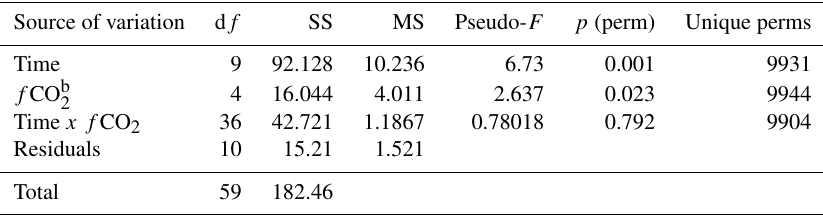
Table 3. Results of two-factor permutational multivariate analysis of variance (PERMANOVA) a on a resemblance matrix (Euclidian distance) based on normalized metabolic variables (bacterial protein production (BPP), areal primary production (PP) and community respiration (CR)). Degrees of freedom (d f ); sum of squares (SS); mean square (MS). Source of variation d f SS Pseudo- F